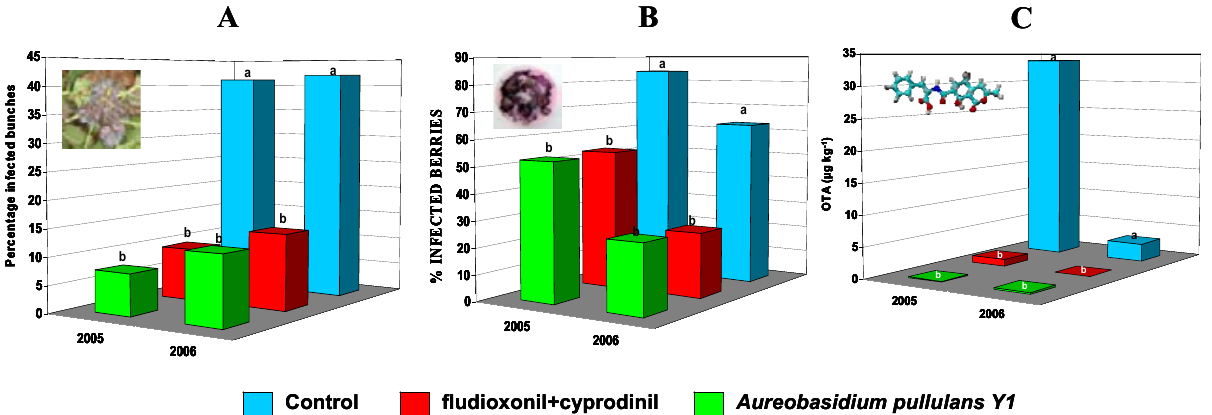
Figure 2. Effect of fludioxonil+cyprodinil and Aureobasidium pullulans Y1 treatments on A) Sour Rot Incidence; B) Aspergil- lus carbonarius populations in grape berries and C) on ochratoxin A content in must. Bars represent the mean percentages for 2005 and 2006 and letters on the top of each bar indicate the results of the Duncan's test (P<0.05); values with different letters in each year are statistically different (Dimakopoulou et al., unpublished data; Dimakopoulou et al., 2008).